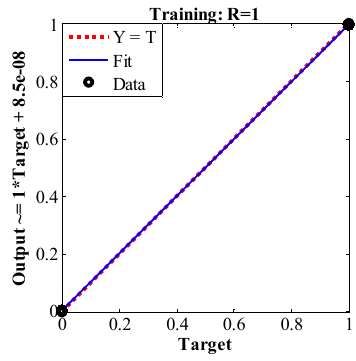
Figure 25. Performance of the hybrid LSA ‐ ANN.